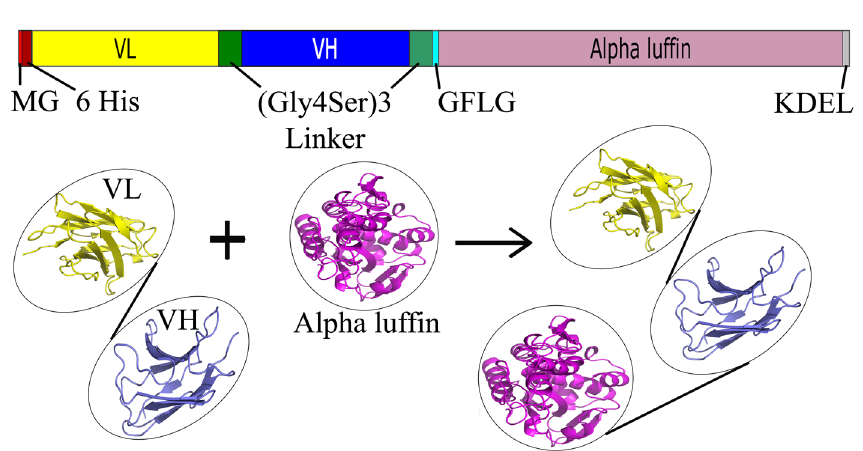
FIGURE 1 - Schematic view of the designed construct. TABLE I - P rediction of primary and secondary structures by ProtParam and CFSSP